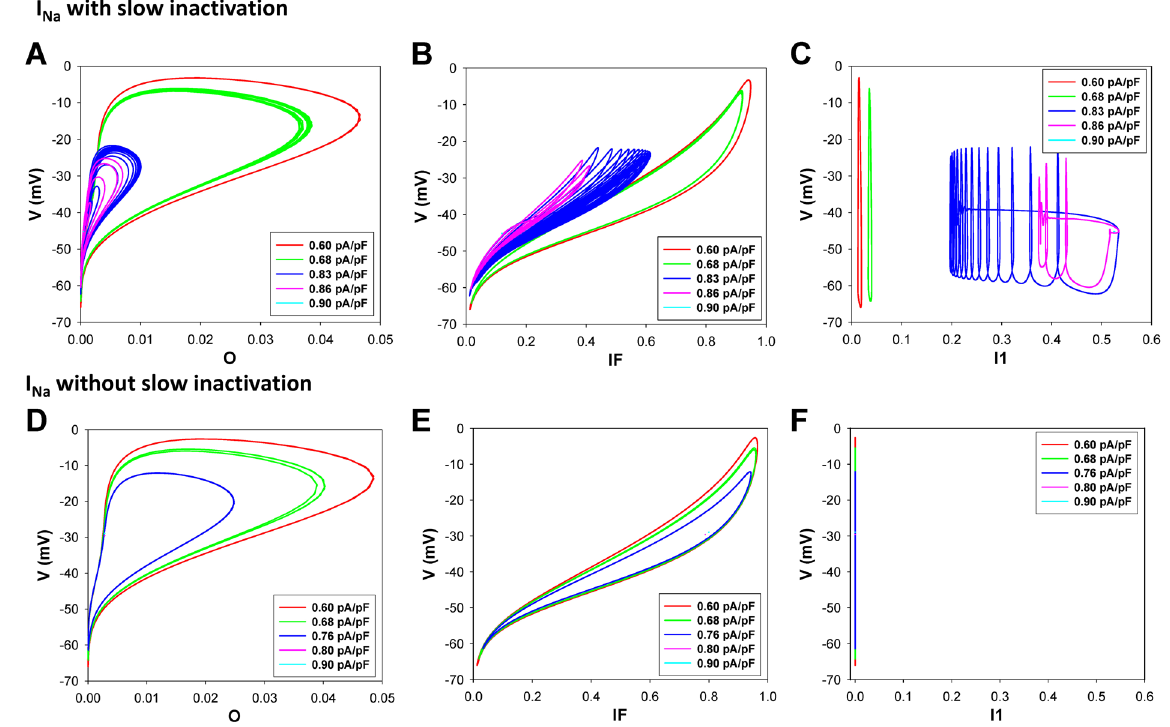
Figure 13. Simulated maps of transmembrane voltage V versus probabilities of the fast Na + channels to be in open (O; Panels A,D), fast inactivated (IF; Panels B,E), and slow inactivated (I1; Panels C,F) states for different values of injected steady-state current I stim in WT cells. I Na with (Panels A–C) and without (Panels D–F) slow